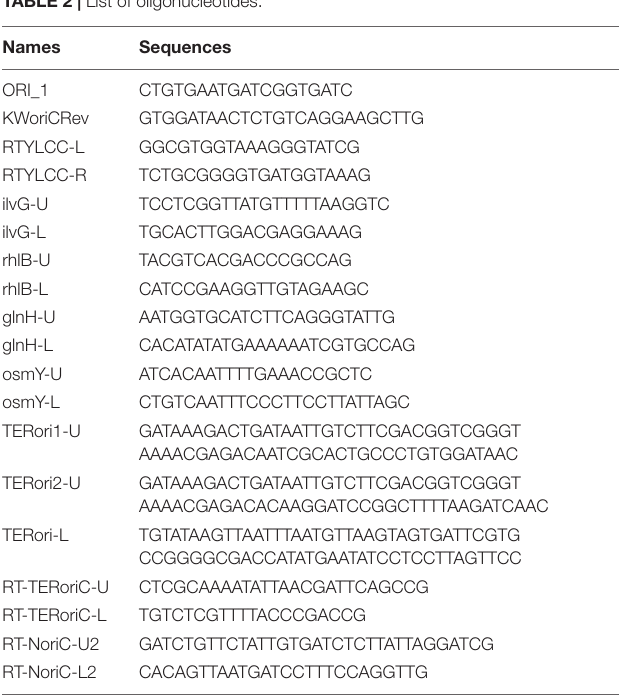
TABLE 2 | List of